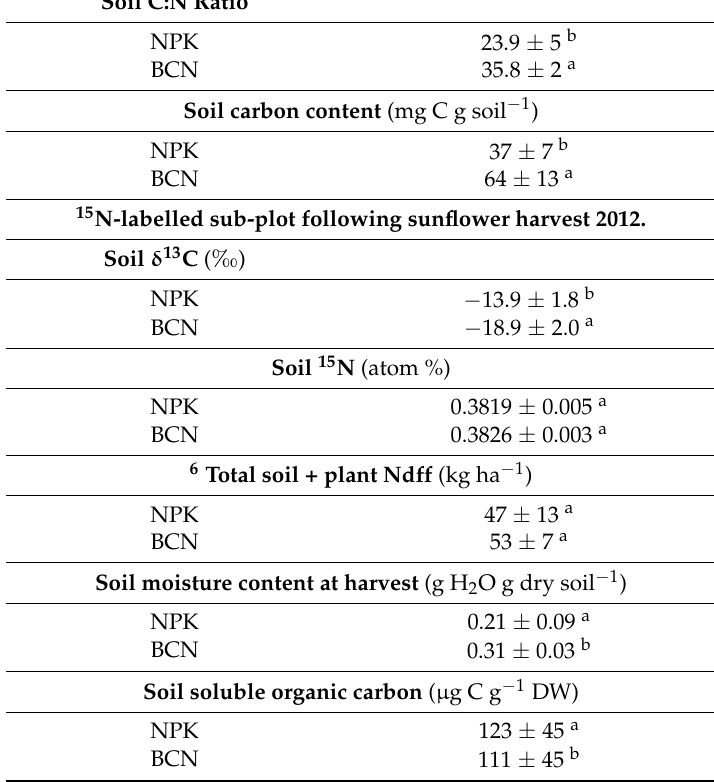
Table 3. Soil data. C:N ratio, carbon content and isotope ratios of the soil following sunflower harvest. Total nitrogen derived from top dressing fertilizer (Ndff) recovered in sunflower and soil following harvest. % moisture content of soil at following harvest in 2012 (all values mean ± standard deviation, n = 4). Different letters indicate significant differences between treatment means within single years, p < 0.05; based on Student’s t -test).